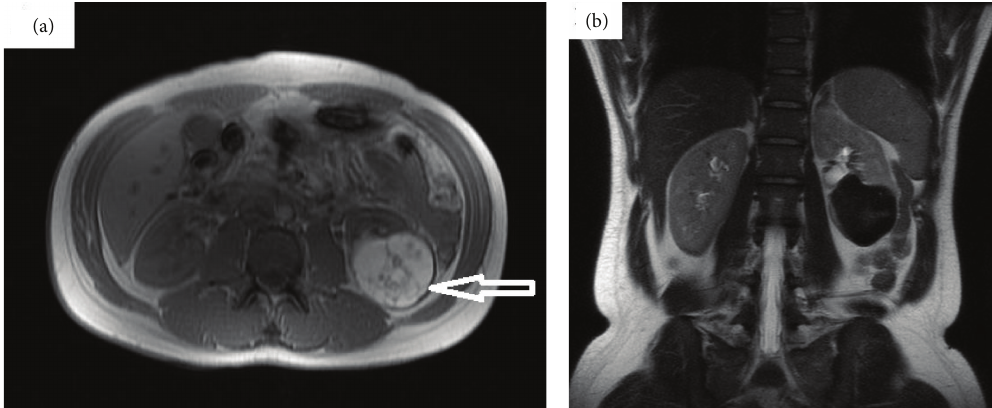
Figure 2: (a) T1-weighted MRI in axial section showing left renal mass with bright signal (see arrow). (b) Left renal lesion is black on this T2-weighted coronal section MRI. No haemorrhagic component was seen.